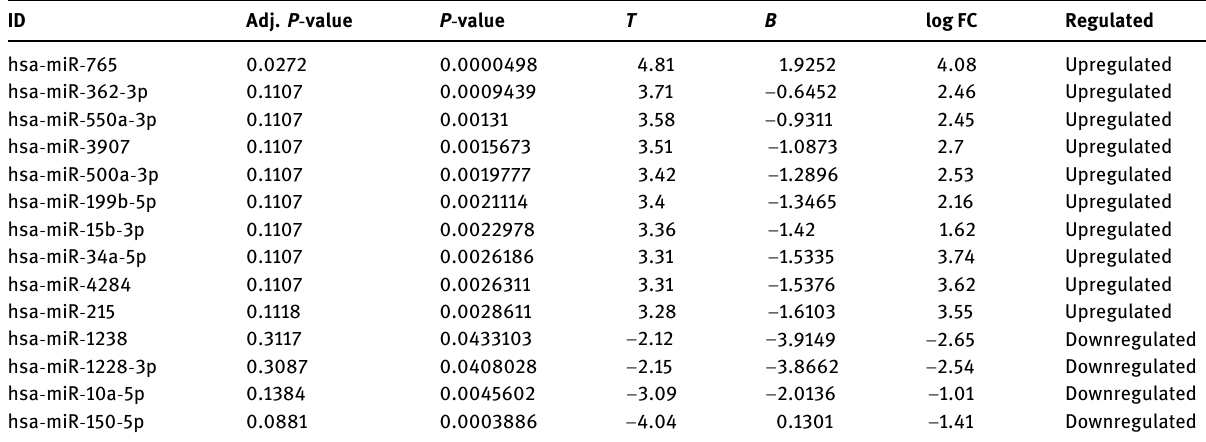
Table 1: Top ten upregulated and all downregulated DE - miRNAs in pEVs between melanoma and health control ID